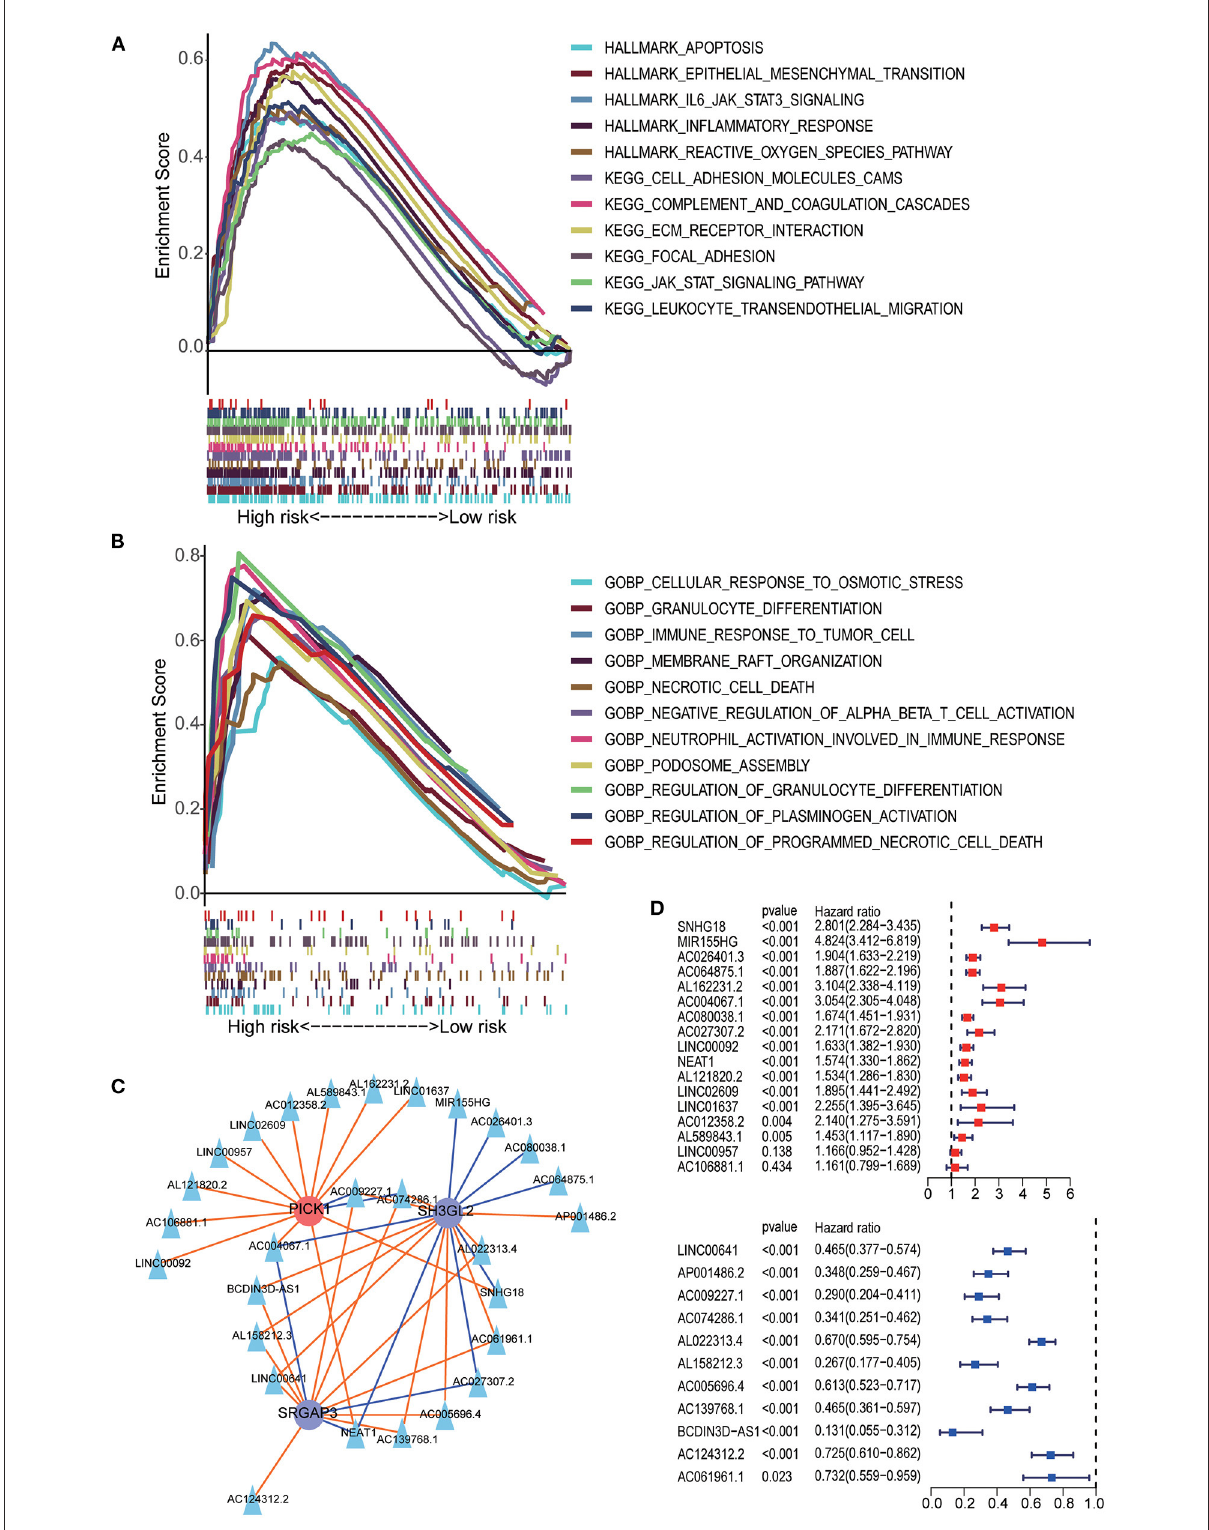
FIGURE7 GSEA analysis between the high- and low-risk groups. (A) HALLMARK and KEGG pathway enrichment analysis. (B) GO BP enrichment analysis. (C) The lncRNA–MTRG regulation network; triangular nodes represent lncRNA, circular nodes represent prognostic MTRG, red circular nodes represent cancer-promoting genes, blue circular nodes represent tumor suppressor genes, red lines indicate upregulation and blue lines indicate downregulation. (D) Univariate Cox regression analysis of lncRNAs negatively correlated with SH3GL2 or SRGAP3 and positively correlated with PICK1. Univariate Cox regression analysis of lncRNAs positively correlated with SH3GL2 or SRGAP3 and negatively correlated with